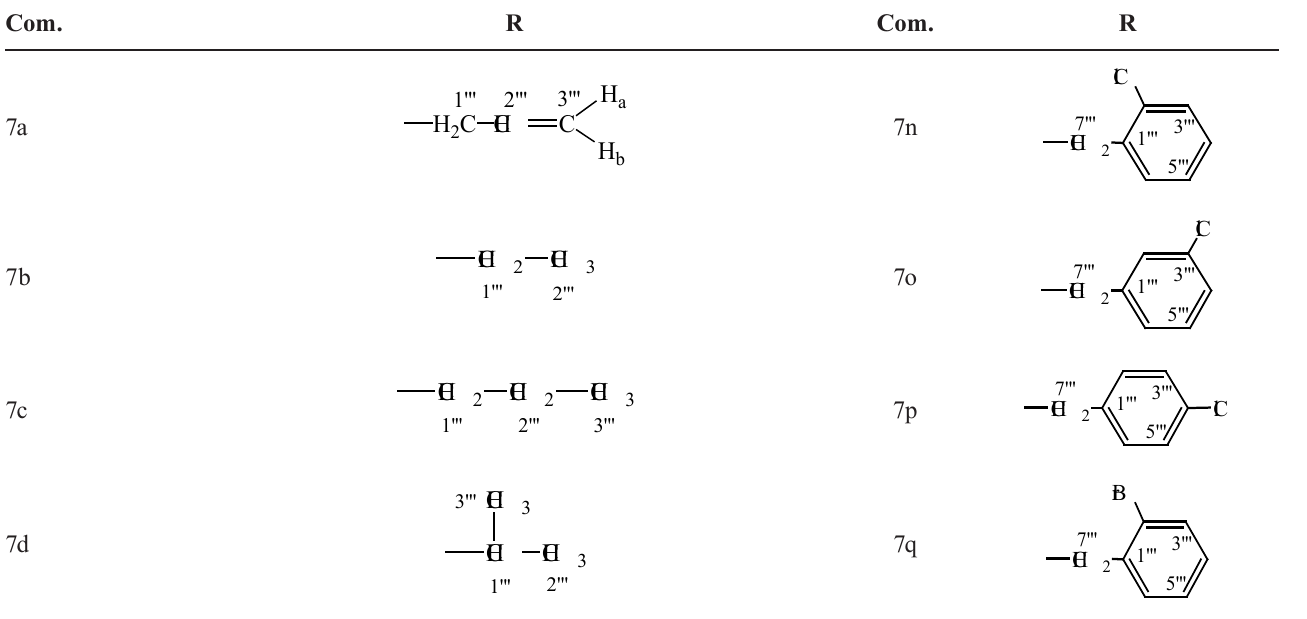
TABLE I - D ifferent alkyl/aralkyl groups